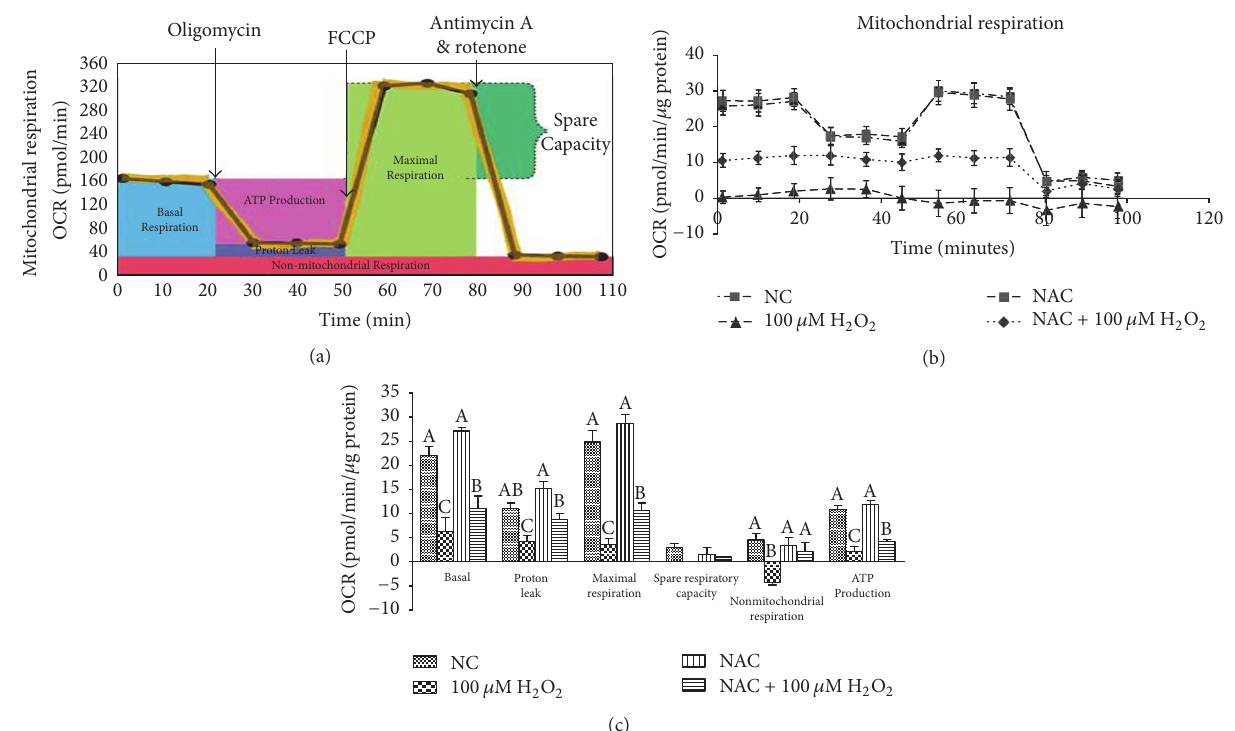
Figure 3: Mitochondrial respiration of IPEC-J2 cells measured by the XF-24 Extracellular Flux Analyzer and Cell Mito Stress Test Kit from Seahorse Biosciences (North Billerica, MA, USA). (a) Schematic and (b) oxygen consumption rate (OCR) assessed by extracellular flux analysis. OCR was measured under basal conditions followed by the sequential addition of oligomycin (0.5 𝜇 M), FCCP (1 𝜇 M), rotenone (1 𝜇 M), or antimycin A (1 𝜇 M). Each data point represents an OCR measurement. (c) Individual parameters for basal respiration, proton leak, maximal respiration, spare respiratory capacity, nonmitochondrial respiration, and ATP production were determined. Cells were treated with 0 (NC) or 800 𝜇 M NAC and 0 or 100 𝜇 M H 2 O 2 , respectively. Data were expressed as means ± SEM of at least three independent experiments. a–c Values with different letters are significantly different ( 𝑃 < 0.05 ).